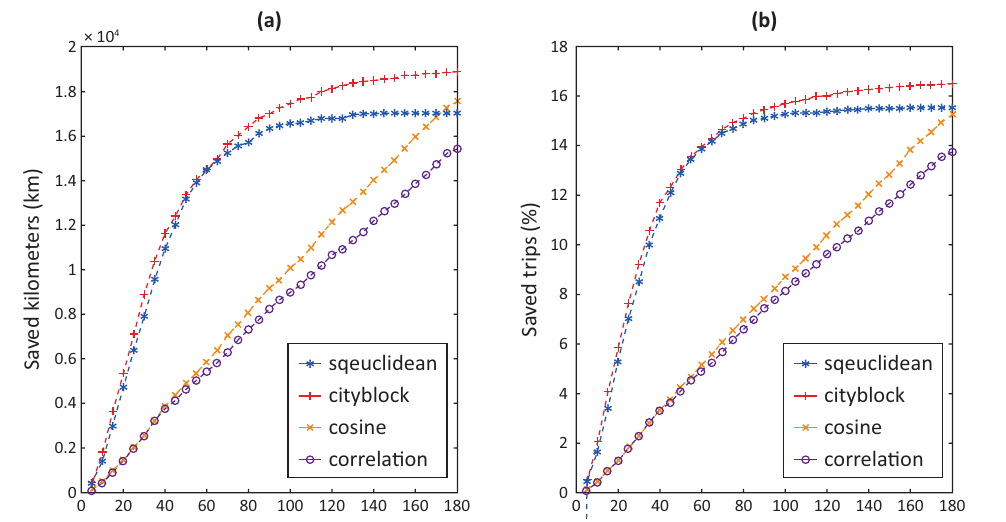
Figure 4. Effect of similarity function and maximum schedule time on (a) saved kilometers (b) number of saved trips.